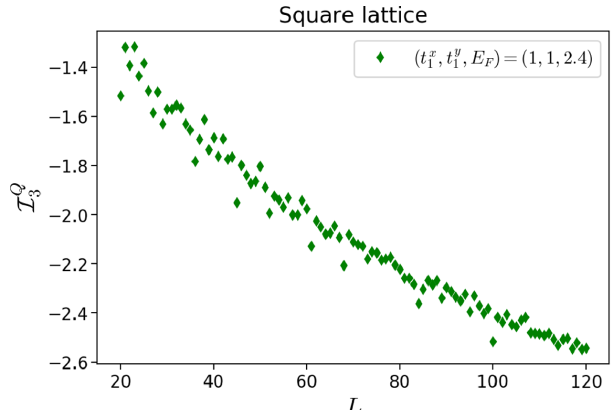
19. I Q 3 ð L Þ in the small L regime with the densest sampling ( Δ L ¼ 1 ), for the case of square lattice with one holelike Fermi surface. Aside from the outliers caused by the boundary effect, there exists additional finite-size noise, presumably caused by